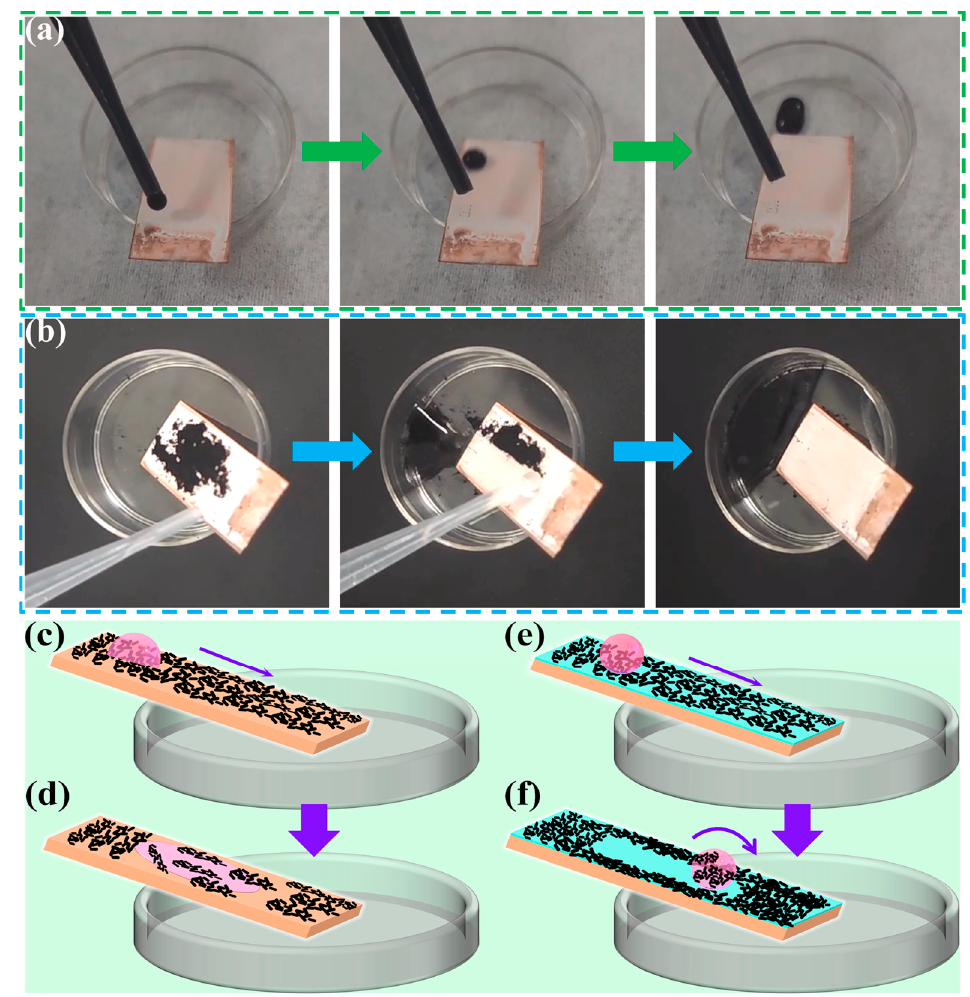
Figure 12. Self-cleaning tests of E-MTES/PFOTS surfaces. ( a ) The ink removal test on E- MTES/PFOTS surface. Self-cleaning testing process of the superhydrophobic surface by ( b ) carbon black powder. Self-cleaning mechanism of droplets on ( c , d ) bare copper and ( e , f ) superhydrophobic surface .